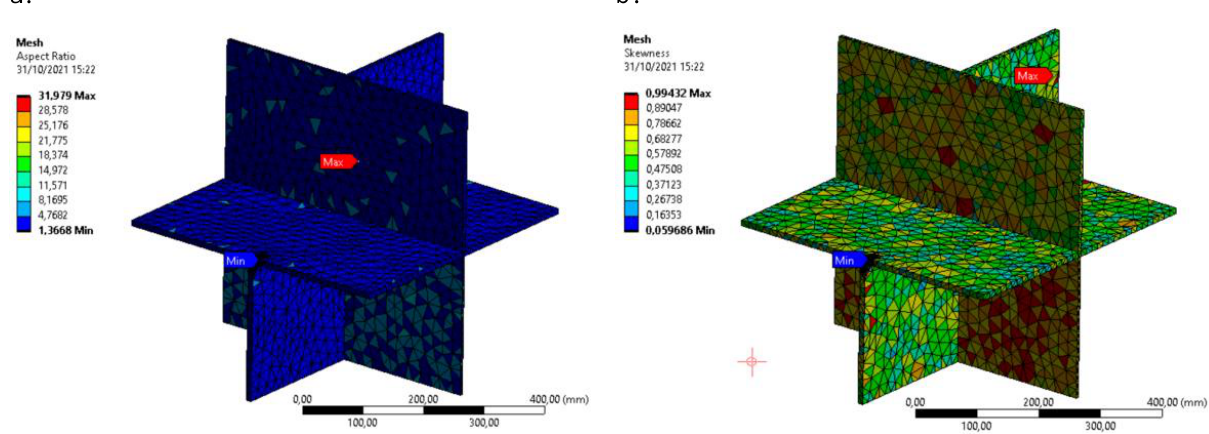
Figure 11. Size 15-mm Mesh Quality: a. Aspect Ratio; b. Skewness Figure 11: Size 15-mm mesh quality: a. Aspect ratio; b.